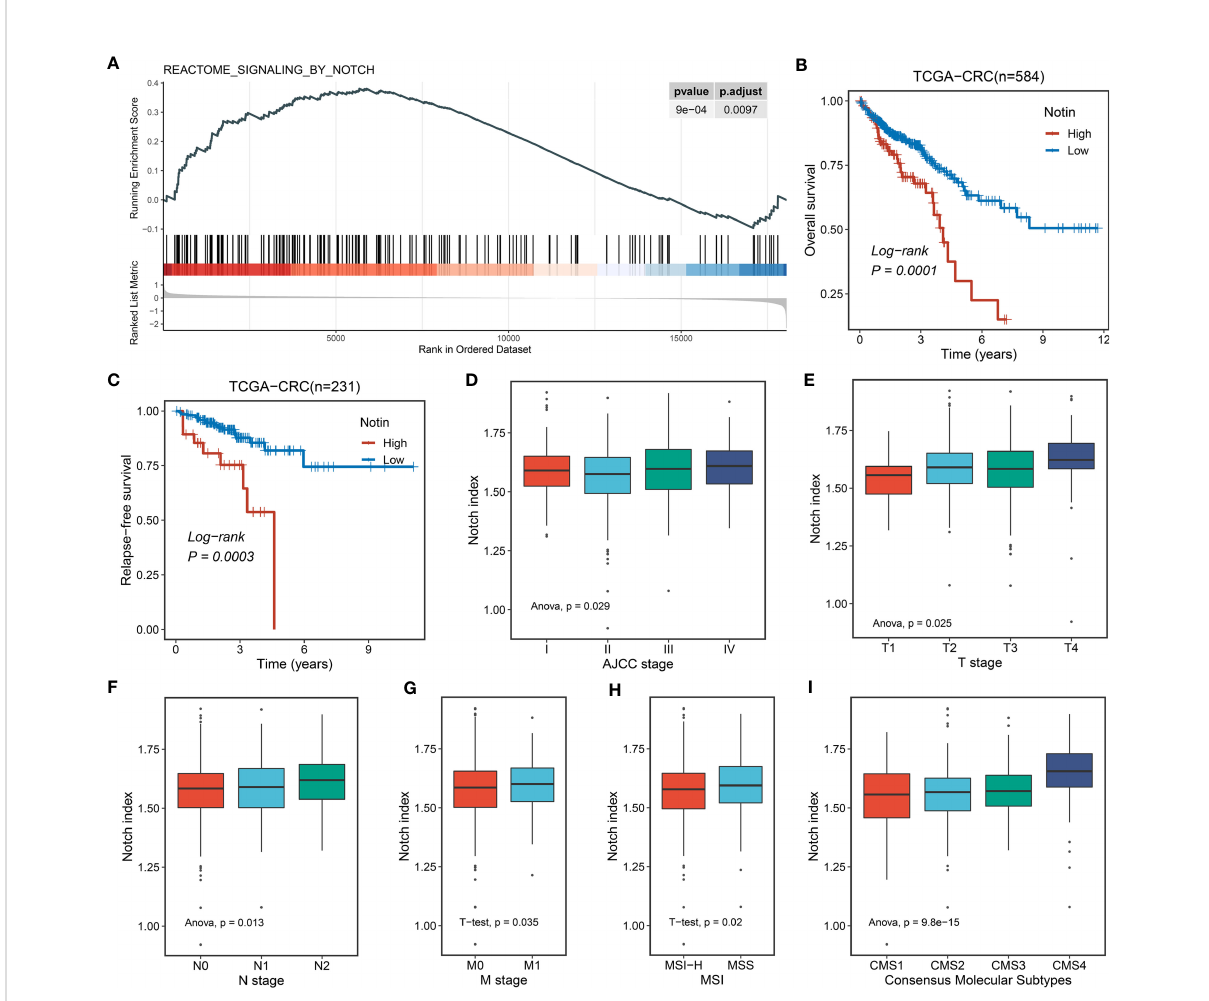
FIGURE 2 The potential biological signi fi cance of the Notch pathway in CRC. (A) Single-sample GSEA (ssGSEA) enrichment analysis of the Notch pathway in TCGA-CRC. (B, C) Kaplan – Meier curves of OS (B) and RFS (C) according to the Notch index (Notin) in TCGA-CRC. (D-H) Correlation between Notin and clinical features, such as AJCC stage (D) , T stage (E) , N stage (F) , M stage (G) , and microsatellite instability (MSI) state (H) of TCGA- CRC. (I) Correlation between Notin and classical consensus molecular subtypes